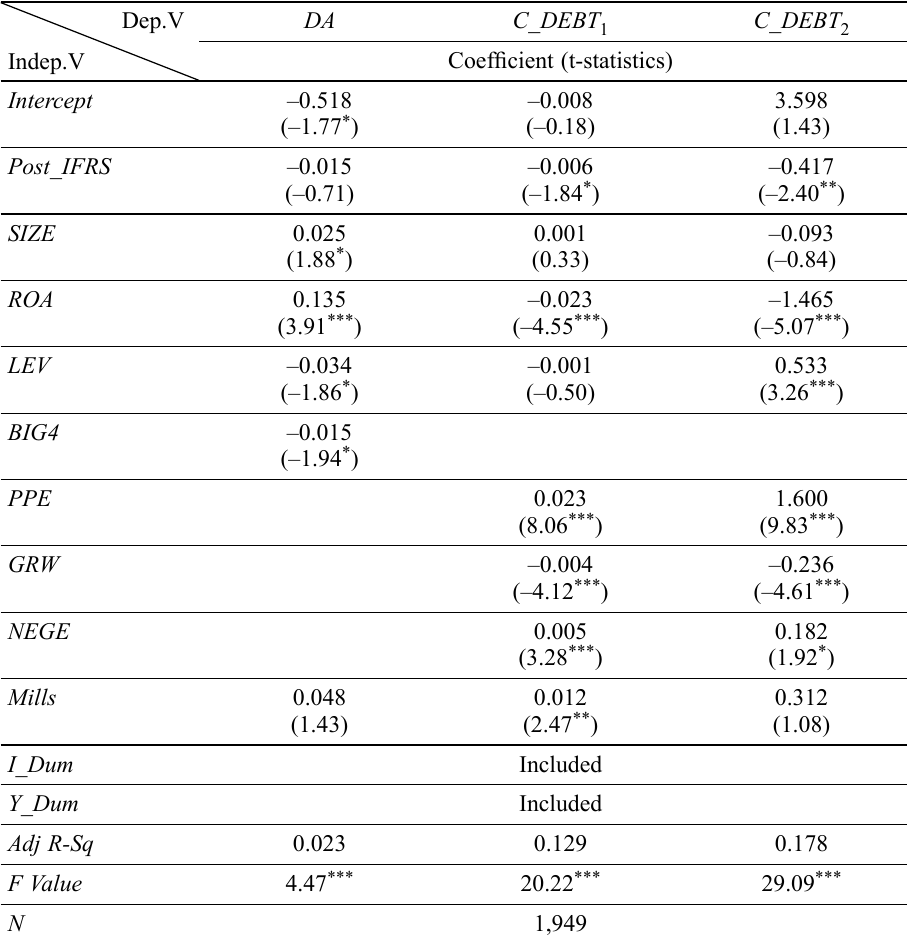
Table 5. OLS regression results of IFRS firms after IFRS